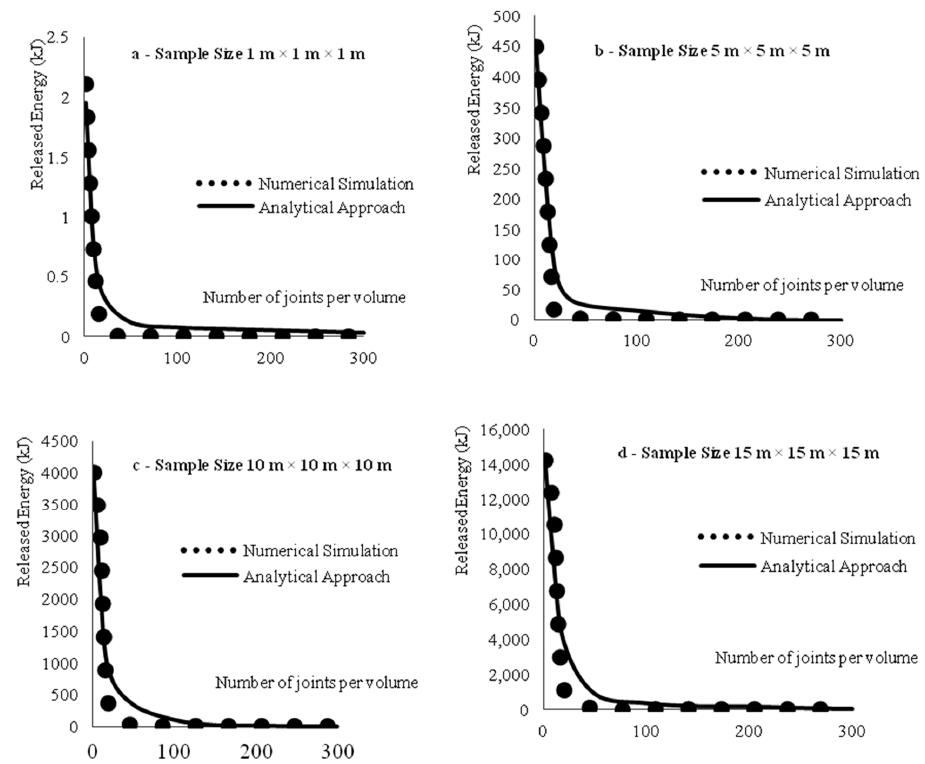
Figure 7. The amount of the released energy in the different coal sample with the different joint densities.